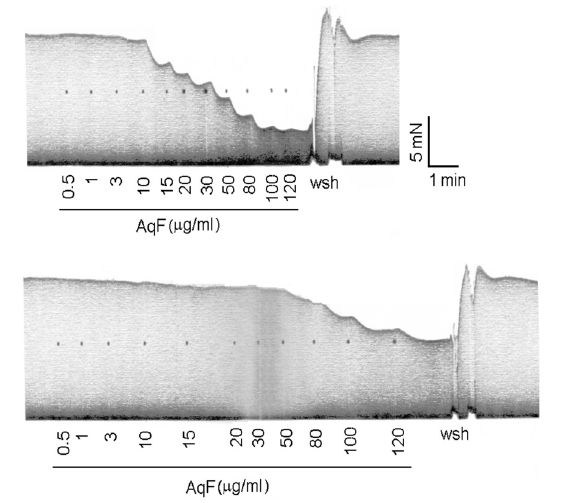
FIGURE 3 - Representative recordings showing the AqF negative inotropic effect obtained before (upper panel) and after (lower panel) adding 20 mM of TEA to the organ bath (wsh: